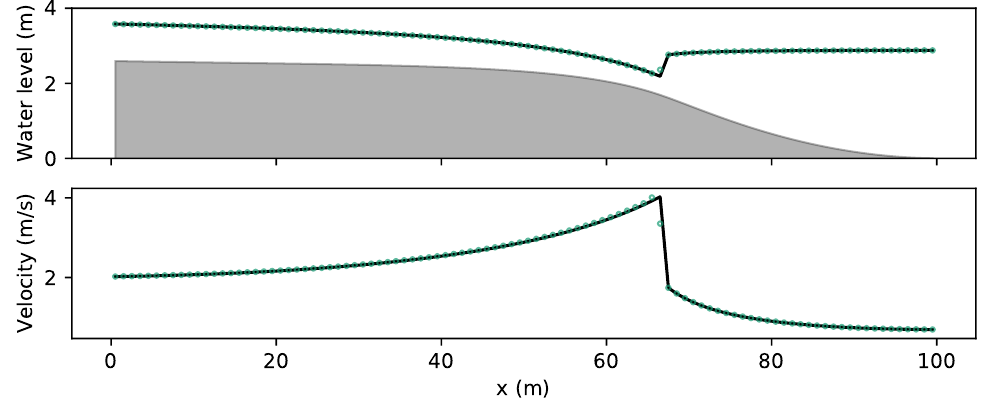
Figure 7. Analytical (black lines) and numerical (green circles) solution for transcritical